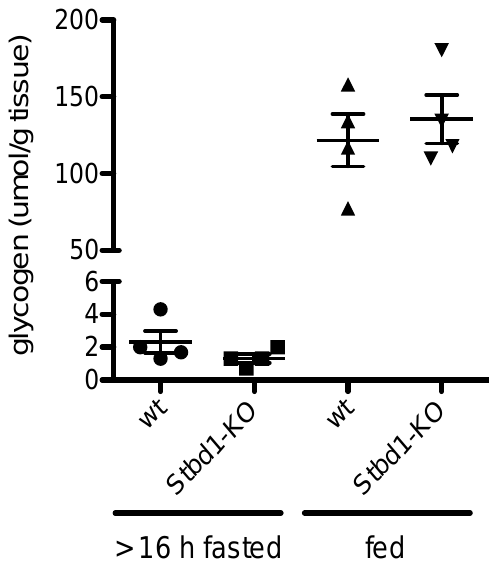
Figure 4. Glycogen concentrations in livers of Stbd1 -knock-out mice after more than 16 h of fasting or in the fed state. Male mice (9 months of age) had access to food ad libitum (fed). The fasted group did not have access to food for 16 h prior to sampling. N = 4 per group, Student’s t -test was not significant.